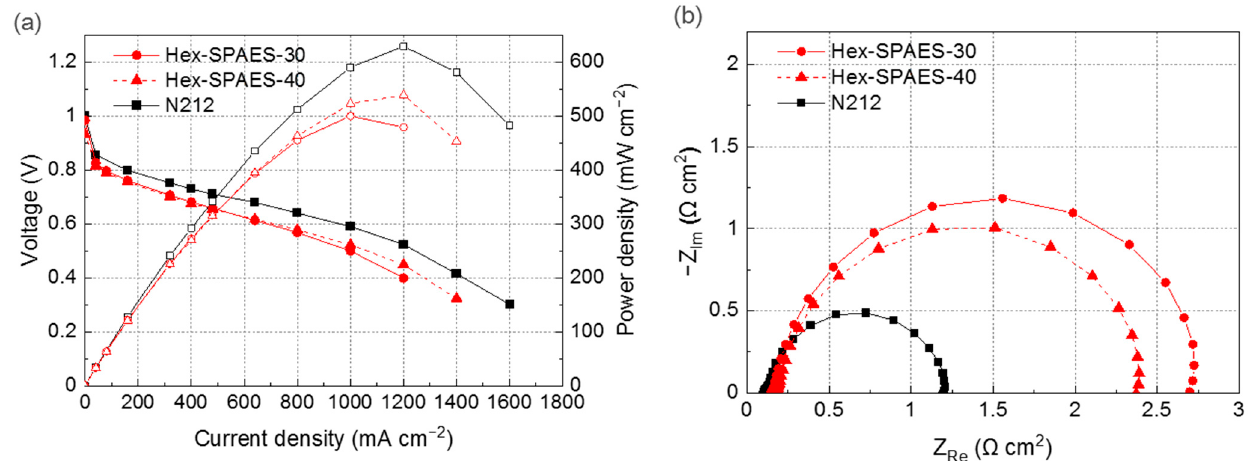
Figure 5. ( a ) Polarization curves and ( b ) EIS curves for the H 2 /Air PEMFCs employing Hex-SPAES-30, Hex-SPAES-40, and Nafion ® N212 membranes.